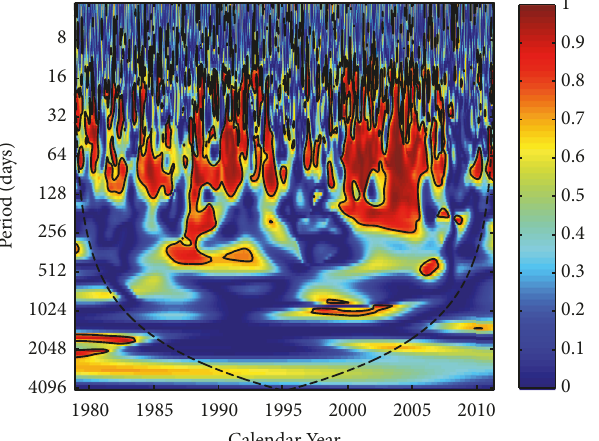
Figure 3: Partial wavelet coherence of the daily TSI and sunspot area (after eliminating the effect of Mg II index). The dashed black line indicates the COI where edge effects might distort the picture, and the 95% confidence level is shown as a thick contour, which is estimated by Monte Carlo